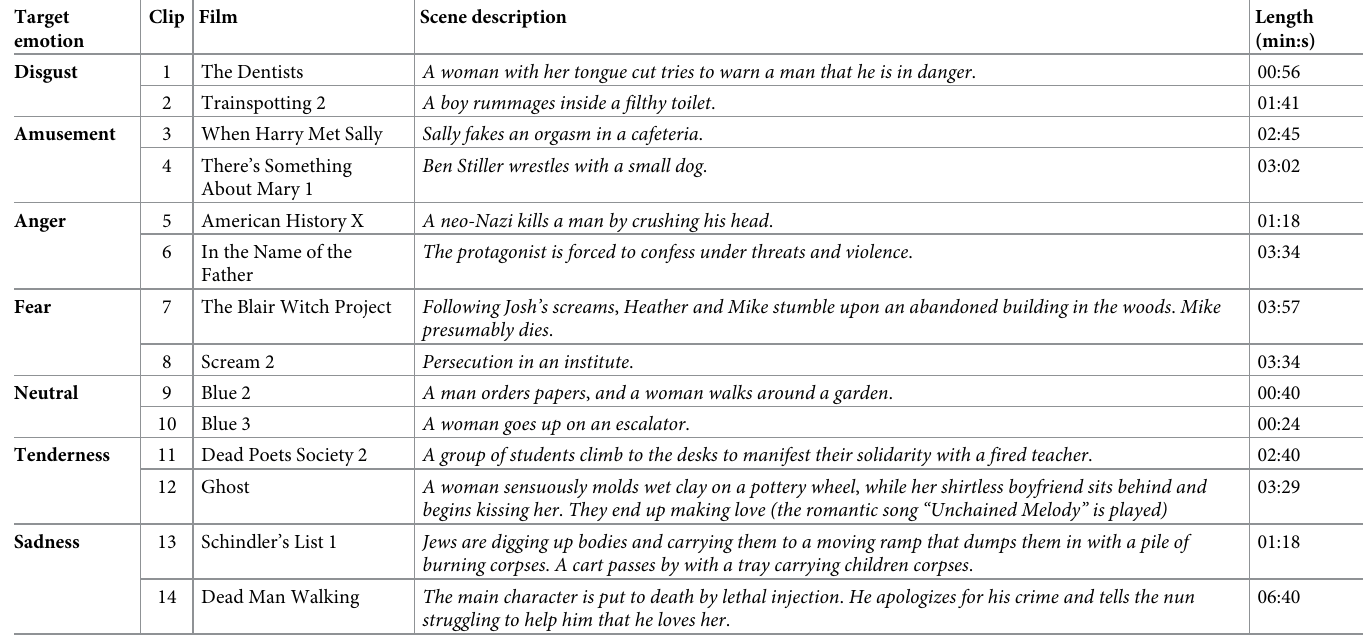
Table 1. Film excerpts for emotion